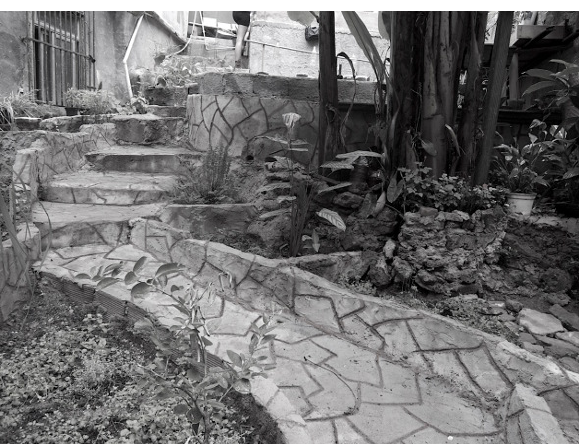
Figure 7. Rocinha Mais Verde .